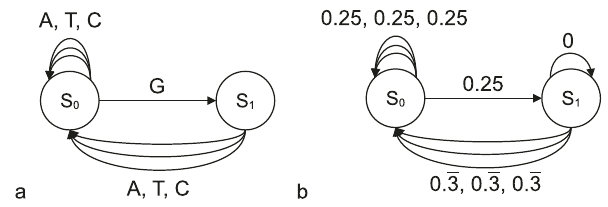
Fig. 8 | State transition example for sequence constraints. With two states, S 0 and S 1 ,andfourpossibleinputs(A,T,C,andG)( a )thatmapto modelprobabilities ( b ): fi nite state transition diagrams for a model in which two consecutive G ’ s are forbidden ( a ) and probabilities as returned by the model ( b